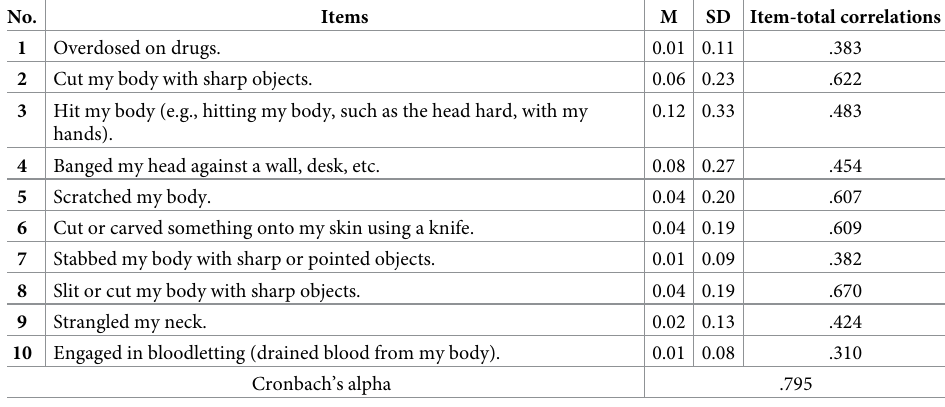
Table 6. Mean, standard deviation, and item-total correlations of the SHSI (N = 514). No. Items M SD Item-total correlations 1 Overdosed on drugs. 0.01 0.11 .383 2 Cut my body with sharp objects. 0.06 0.23 .622 3 Hit my body (e.g., hitting my body, such as the head hard, with my 0.12 0.33 .483 hands). 4 Banged my head against a wall, desk, etc. 0.08 0.27 .454 5 Scratched my body. 0.04 0.20 .607 6 Cut or carved something onto my skin using a knife. 0.04 0.19 .609 7 Stabbed my body with sharp or pointed objects. 0.01 0.09 .382 8 Slit or cut my body with sharp objects. 0.04 0.19 .670 9 Strangled my neck. 0.02 0.13 .424 10 Engaged in bloodletting (drained blood from my body). 0.01 0.08 .310 Cronbach’s alpha .795